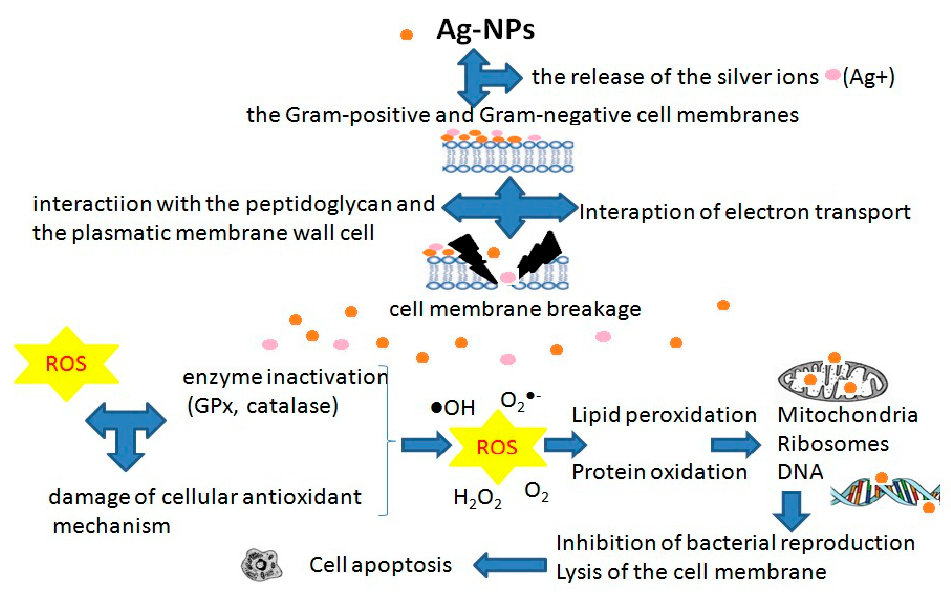
Figure 4. Mechanisms of Ag ‐ NPs’ antimicrobial activity.